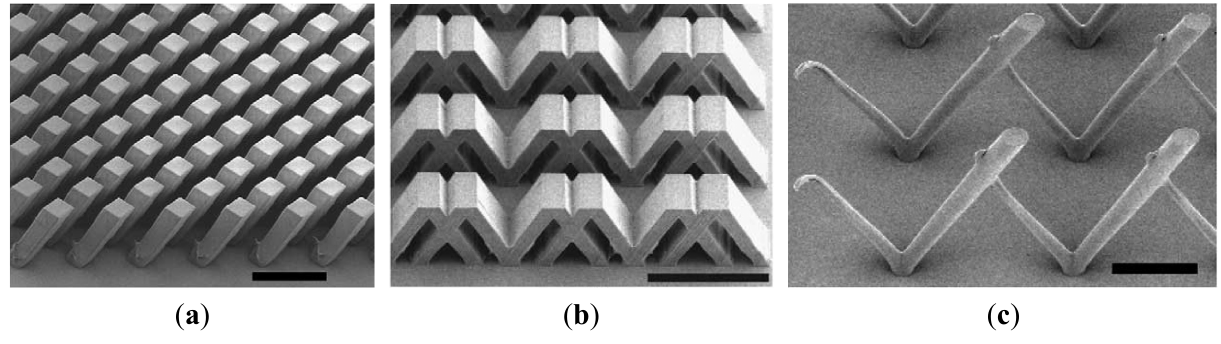
Figure 1. SEM (scanning electron microscope) images of the ( a ) single inclined UV exposure (scale bar 100 μ m); ( b ) double inclined UV exposure (scale bar 200 μm) and ( c ) single inclined exposure with enhanced reflection at the surface (scale bar 100 μm)